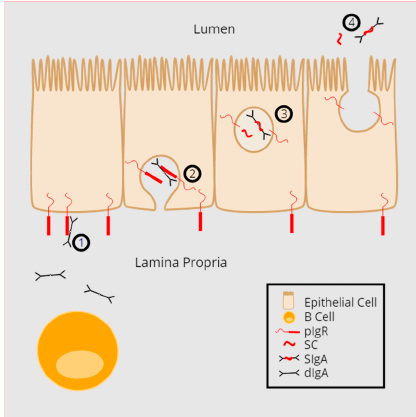
Figure 1. Transport of polymeric immunoglobulins (pIg) to the mucosal surface. (1) p Ig (dimeric IgA